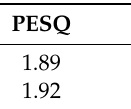
Figure 9. Spectrogram examples of dereverberated signal by ( a ) the RIR method and ( b ) the pro- posed method. Table 2. Performance of dereverberation.